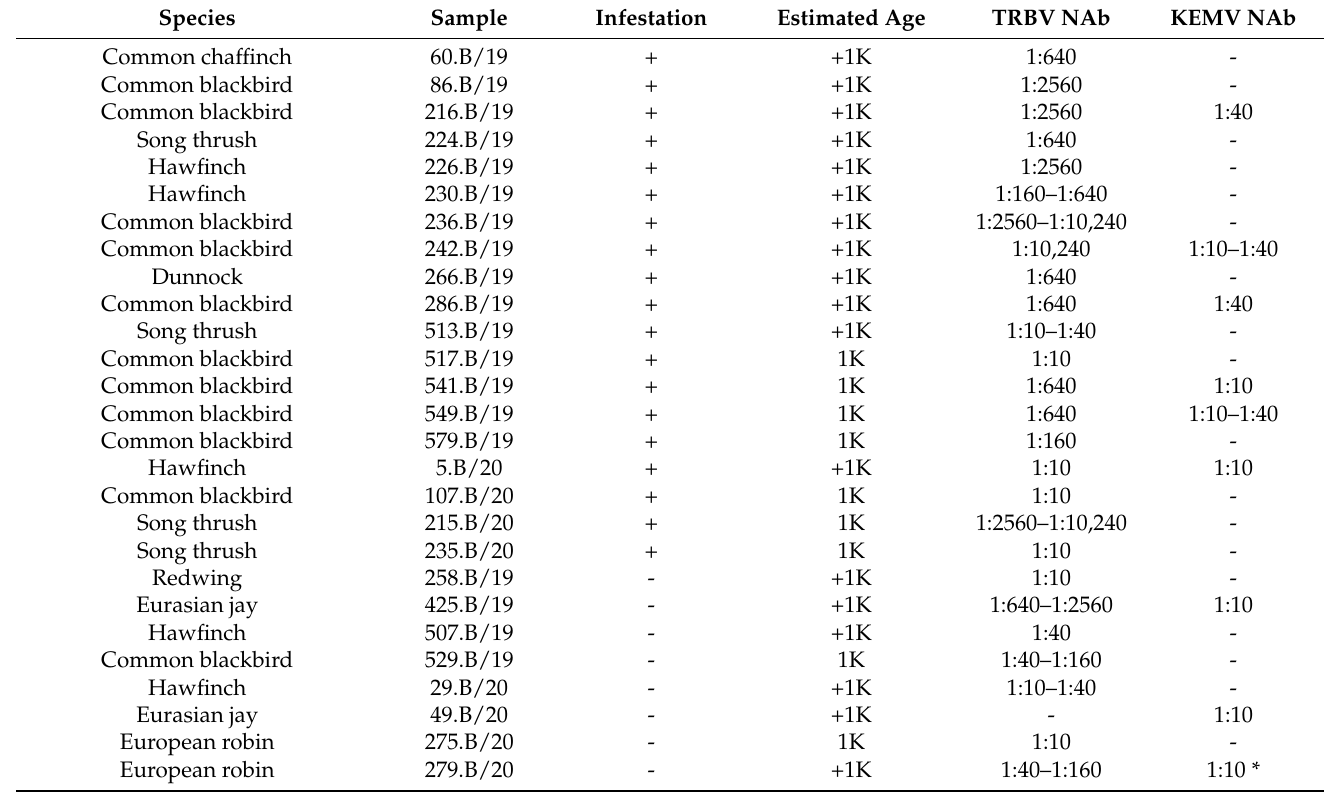
Table 5. Determination of TRBV and KEMV infections by simultaneous µ